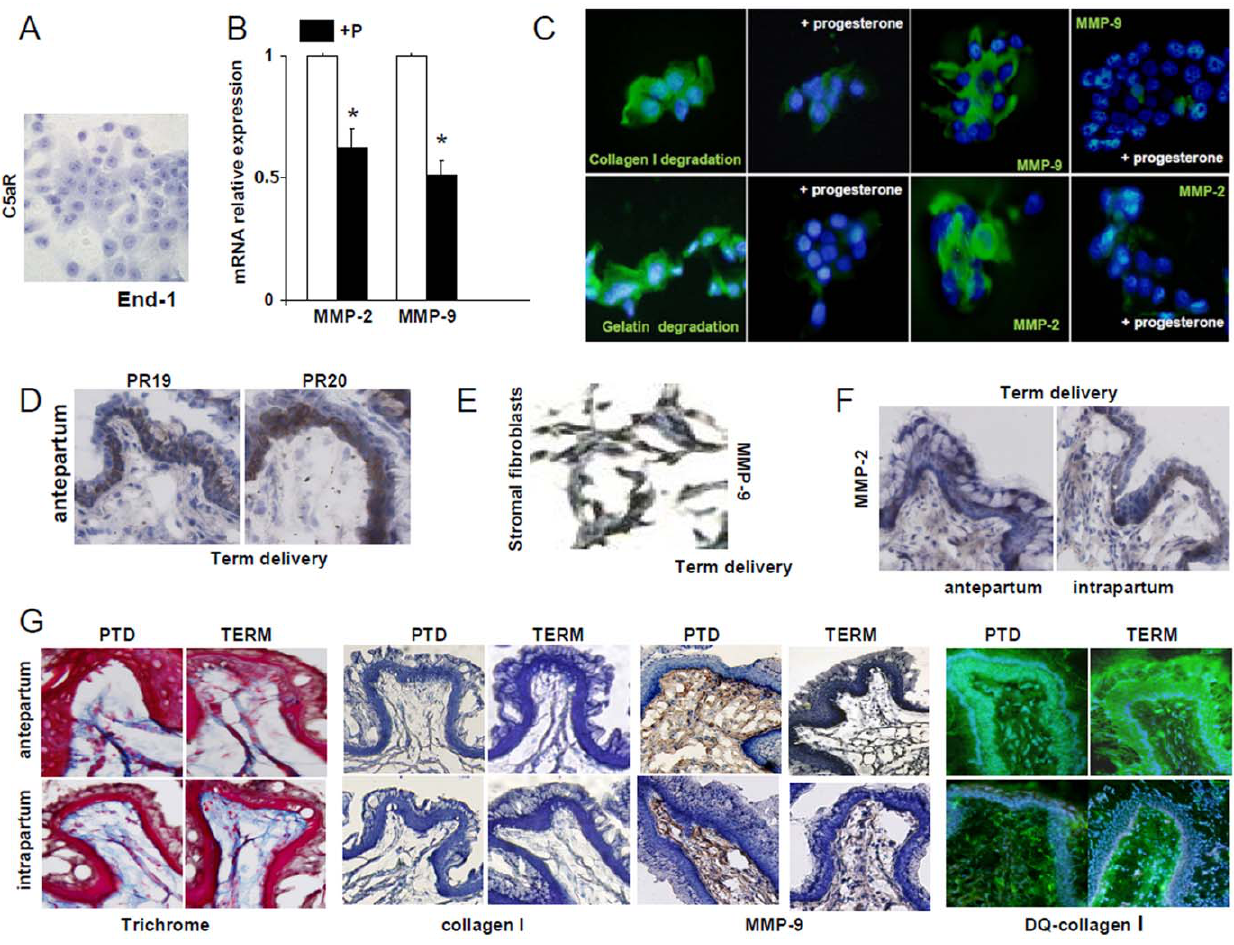
Figure 4. Cervical MMPs activity and collagen degradation at PTD and term delivery. A- Immunohistochemical determination of C5aR in End-1 cervical columnar epithelial cells. n=4. B– Relative quantification of MMP-2 and MMP-9 between End-1 cells incubated with and without progesterone. * p , 0.05, n=4 mice/group. Note that in End-1 cells incubated with progesterone a , 50% reduction in MMP-2 and MMP-9 mRNA was observed when compared to untreated cells. C- In situ zymography using substrates DQ-gelatin and DQ-collagen I and immunohistochemical detection of MMP-2 and MM9-9 en End-1 cells incubated with and without progesterone. The green fluorescence indicate the substrate has been digested. MMP-2 and MMP-9 were detected by IHC using specific antibodies followed by FITC-labeled secondary antibodies. D- Immunohistochemical detection of progesterone receptors PR-19 and PR-20 in the cervix of mice during antepartum at term. 4 slides per animal were stained and 6–8 animals were studied in each group. E- Trichrome staining, staining for collagen I and for MMP-9 and in situ zymography using DQ-collagen I in cervical tissue harvested antepartum and prepartum from mice that deliver preterm and at term. 3–4 slides per animal and 5 to 6 mice/group were used for immunohistochemical studies. Original magnification is 6 20. F- Immunohistochemical determination of MMP-9 in cervical stromal fibroblasts at term. 4 slides per animal were stained and 6–8 animals were studied in each group. G- Immunohistochemical determination of MMP-2 in cervical columnar epithelial and stromal cells at term during antepartum and intrapartum. 4 slides per animal were stained and 6–8 animals were studied in each group.